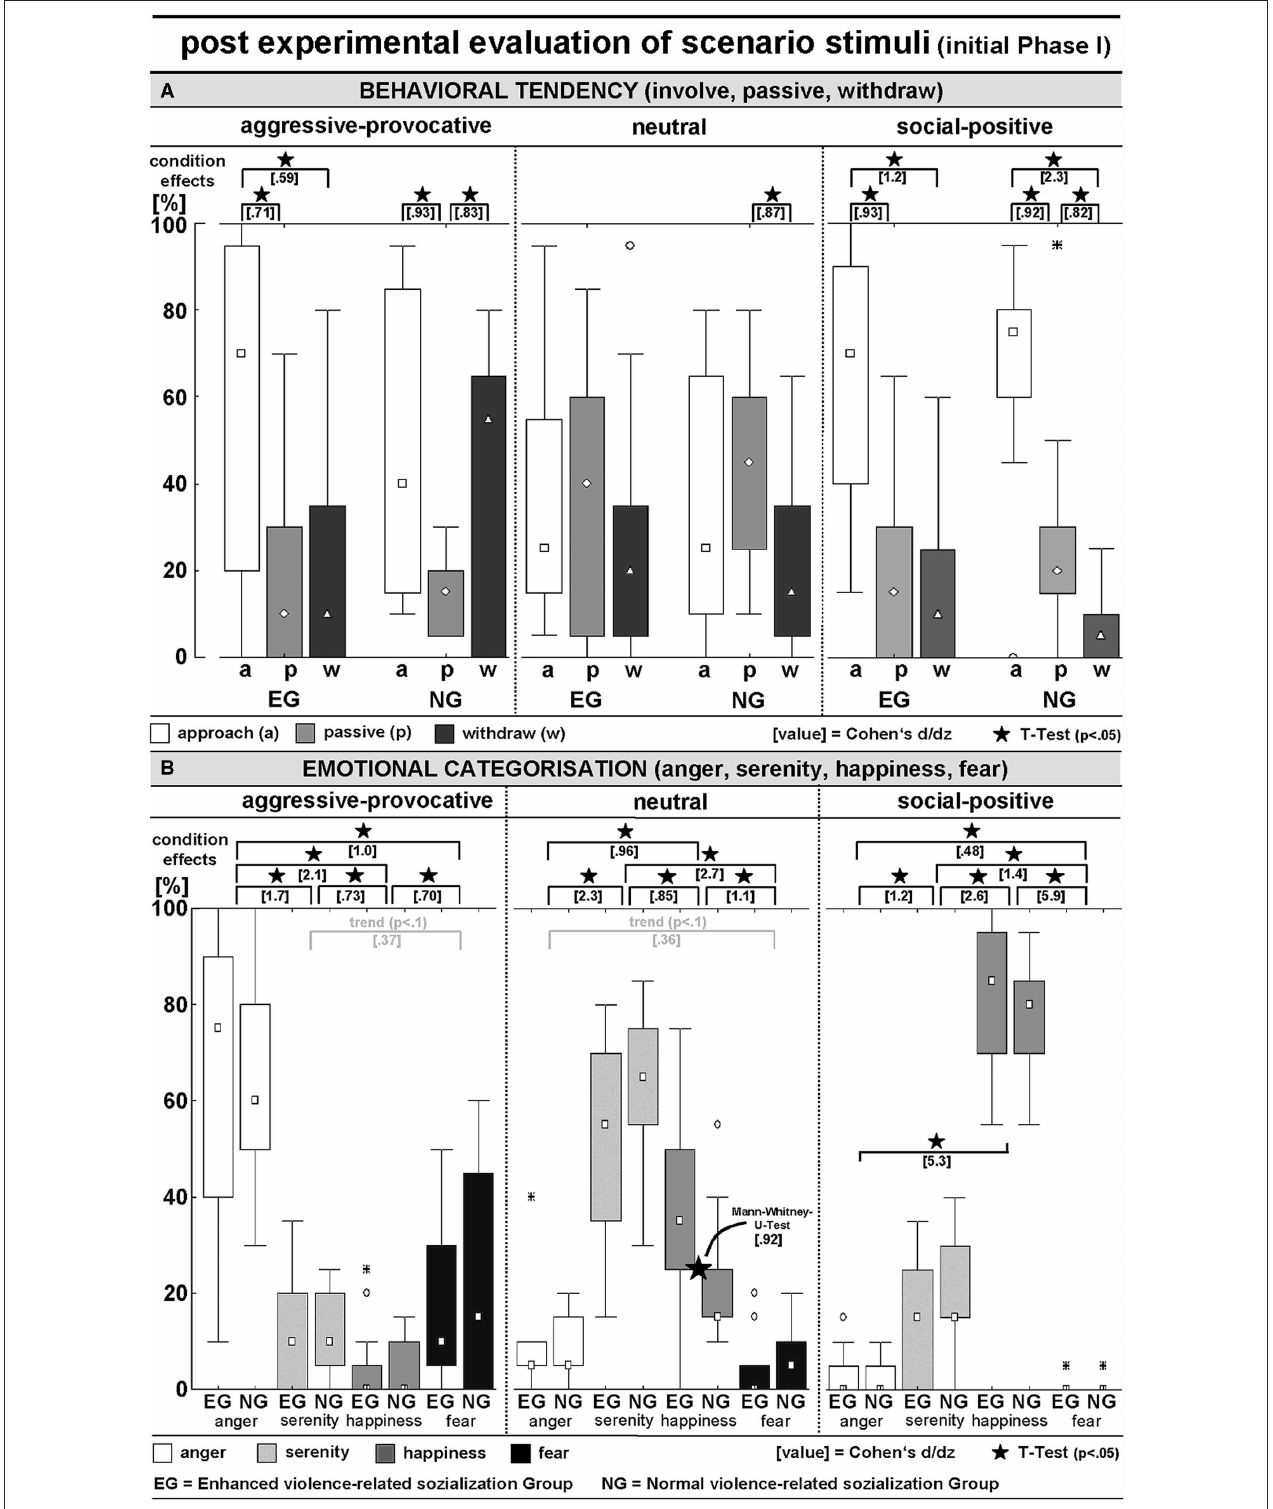
FIGURE 3 | Post hoc evaluation of PHASE I of the video clips concerning (A) interaction-related behavioral tendency (approach, behave passively, or withdraw) and (B) interaction-related emotional appraisal (scenarios induced anger, serenity, happiness, or fear); see Table 1 for detailed numerical information.